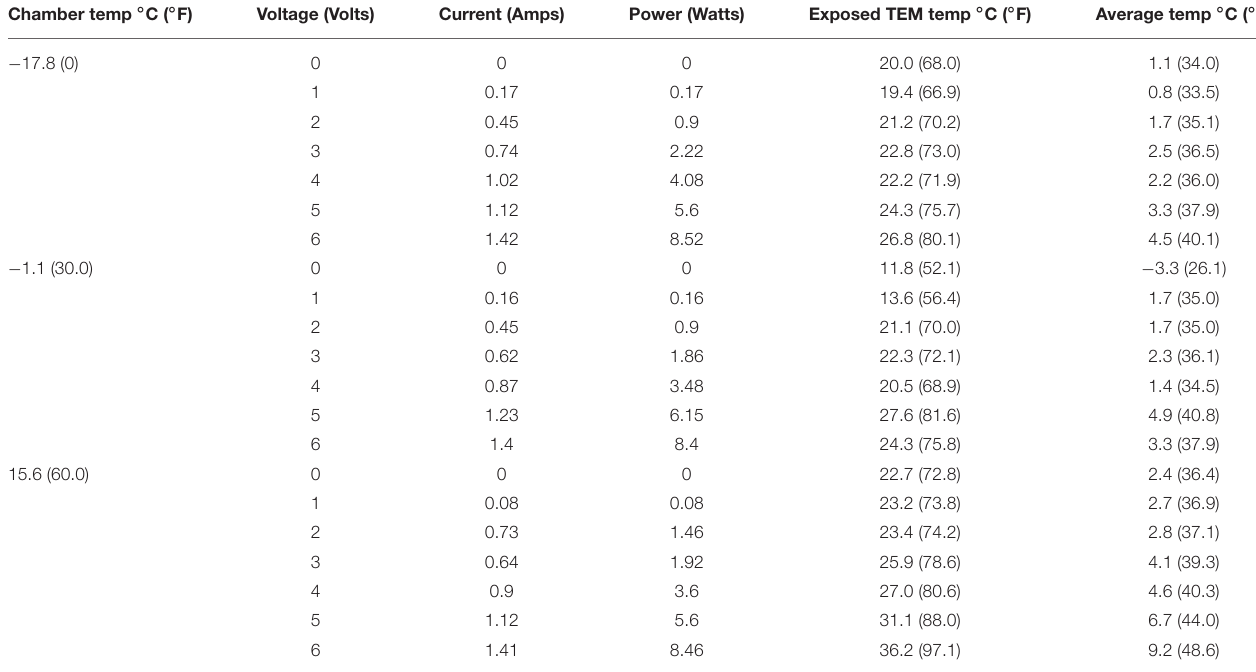
TABLE 1 | Results of thermal testing (heating